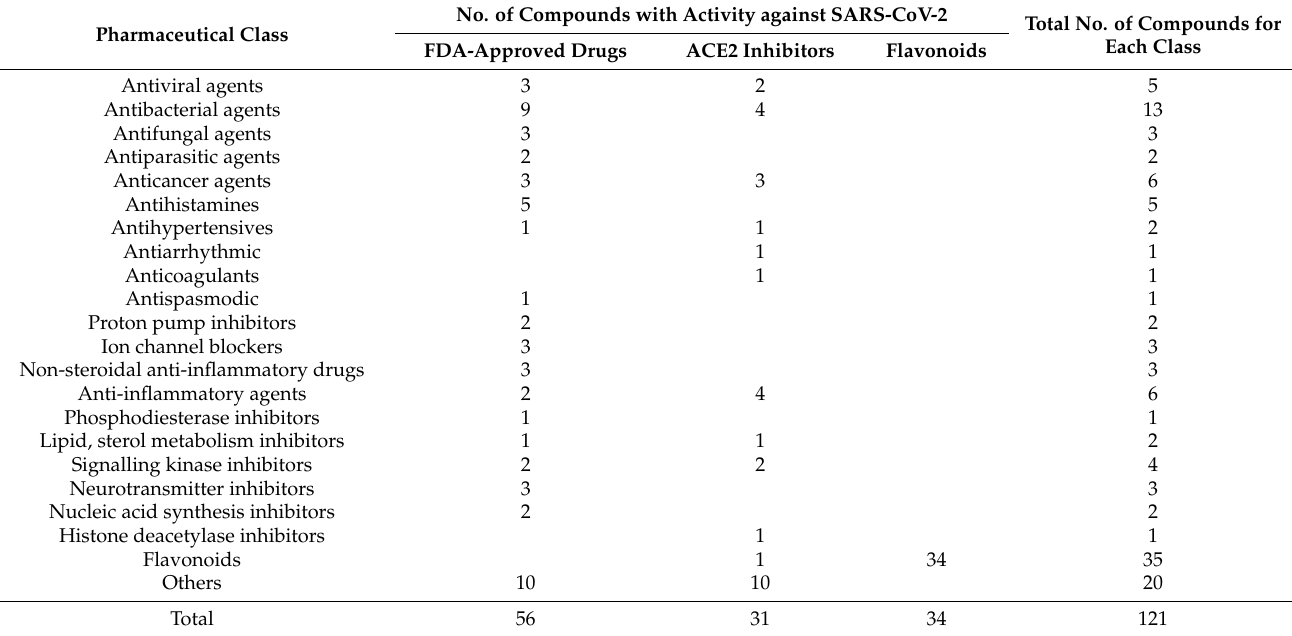
Table 1. Primary hits selected for further validation against SARS-CoV-2